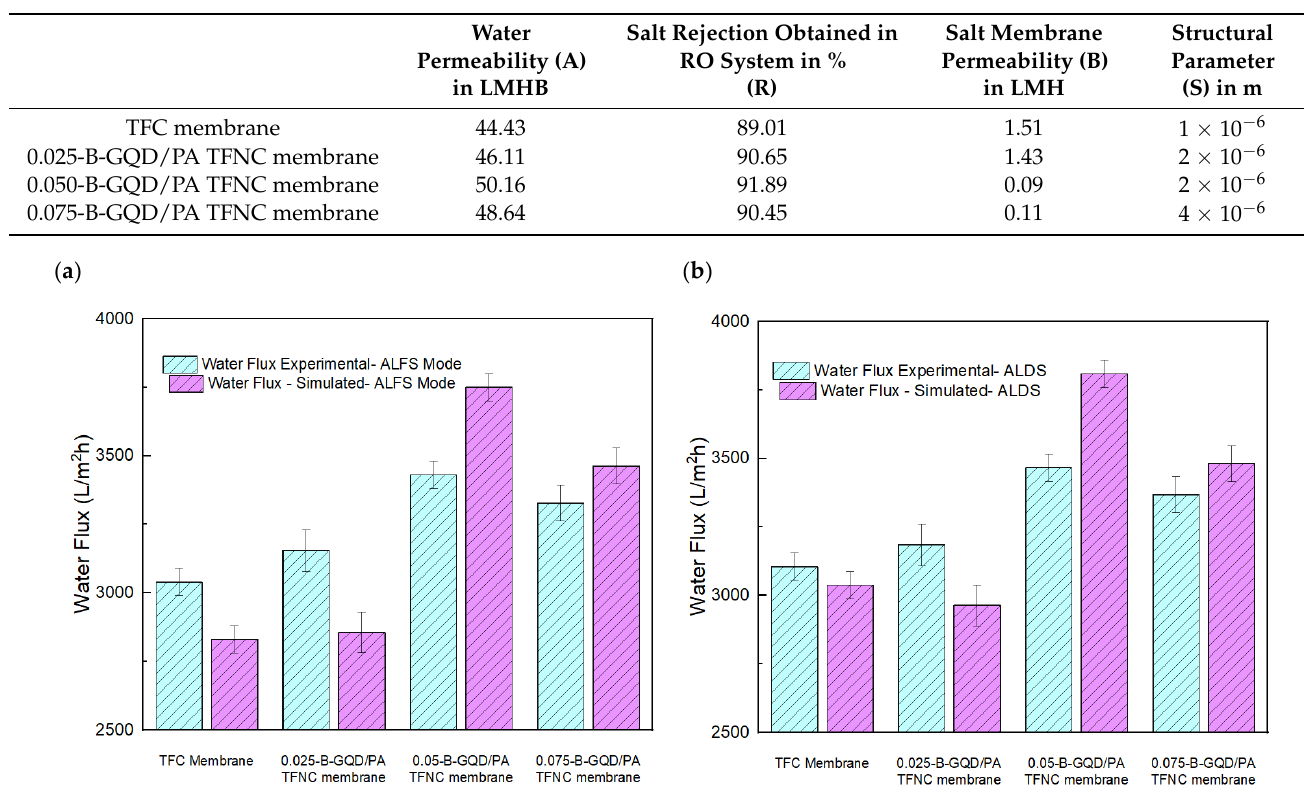
Table 2. Membrane-intrinsic property evaluation results.